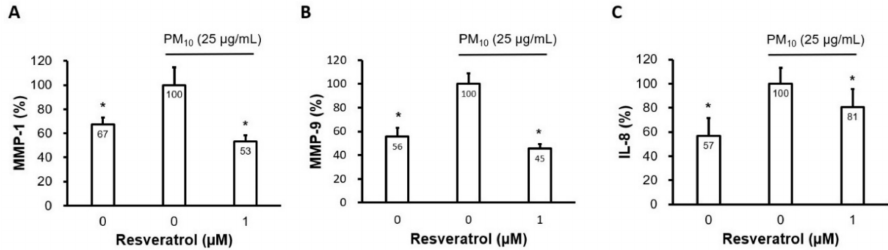
Figure 4. E ff ect of resveratrol on the production of proinflammatory cytokines in human keratinocytes following PM treatment. ( A ) Protein levels of MMP-1, ( B ) MMP-9, and ( C ) IL-8 were determined using ELISA. Cells were pretreated with resveratrol (1 µ M) for 6 h and subsequently incubated with PM 10 (25 µ g / cm 2 ) for 24 h. Keratinocyte culture supernatants were collected and used for further analyses. Data are presented as the mean ± standard deviation of three independent experiments ( n = 3). * p < 0.05 vs. PM-treated, resveratrol-untreated control, PM, particulate matter, IL, interleukin, MMP, matrix metalloproteinase, ELISA, enzyme-linked immunosorbent